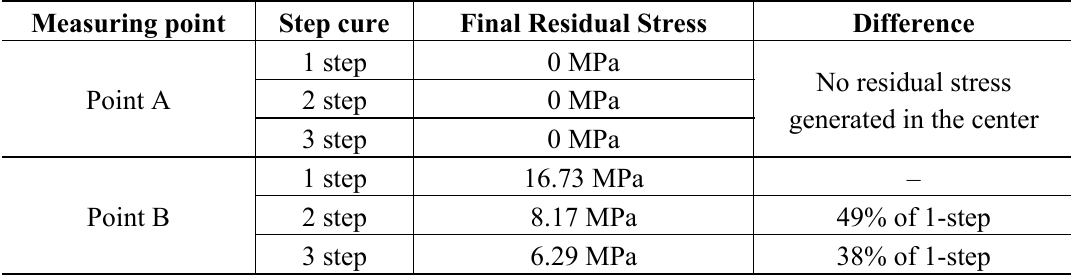
Table 3. Comparison of final residual